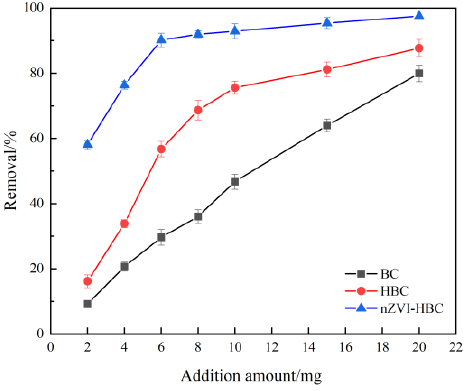
Figure 5. The effect of biochar addition on OTC removal rate.